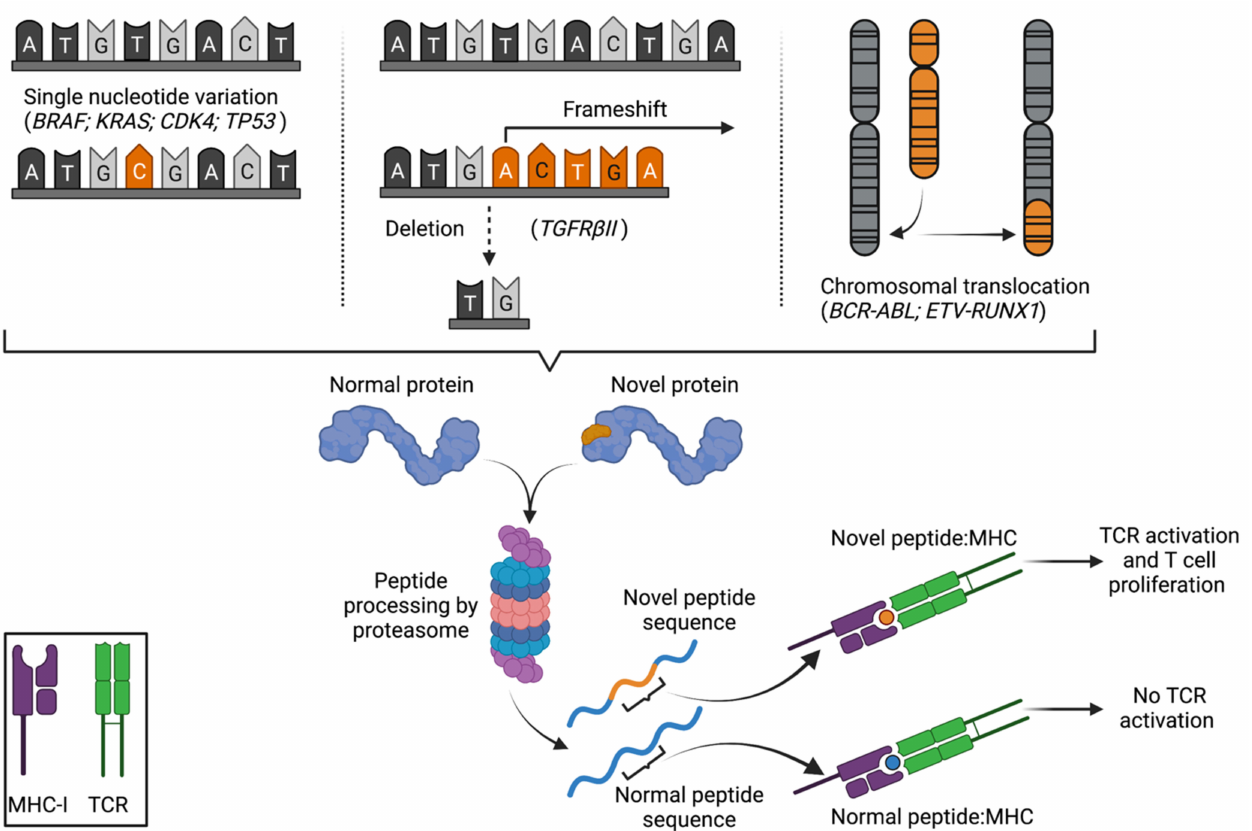
Figure 1. Generation and recognition of neoantigenic peptides after mutational or structural changes to somatic DNA. Changes to coding nucleotide sequence can be generated by non-synonymous point mutations, insertion/deletion events leading to reading frameshifts, or larger-scale structural changes such as chromosomal translocation and gene fusion events. When these changes to somatic DNA cause an alteration in amino acid sequence creating a peptide that can be processed and presented in the context of MHC-I/II and induce TCR activation, such a peptide is designated a